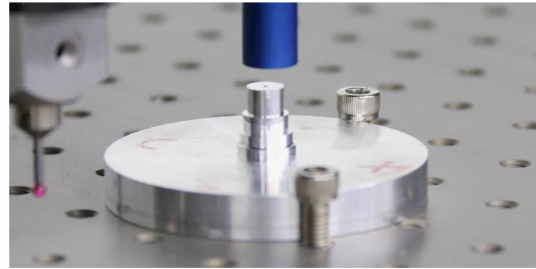
Figure 12. The standard measured by multiple sensors.